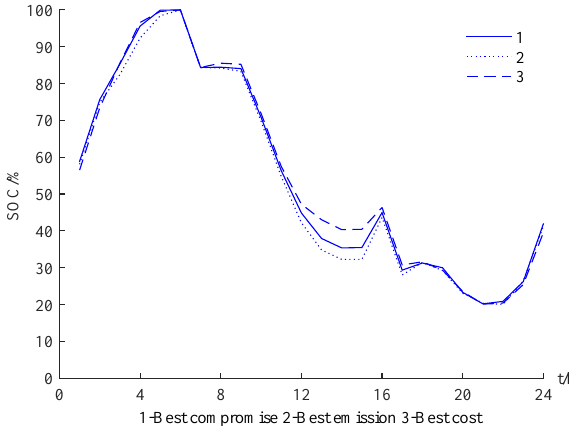
Figure 11. Comparison of EVs SOC different solutions.